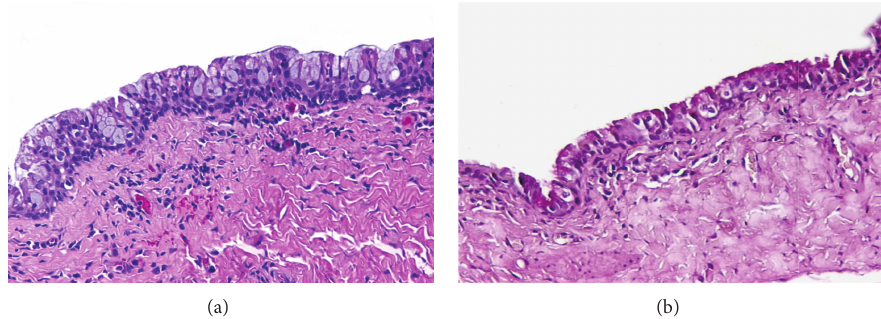
Figure 3: (a) Columnar epithelium with scattered goblet cells. (b) Bright pink mucin secretion in goblet cells ((a) hematoxylin and eosin and (b) mucicarmine, magnifications (a) and (b) × 200).